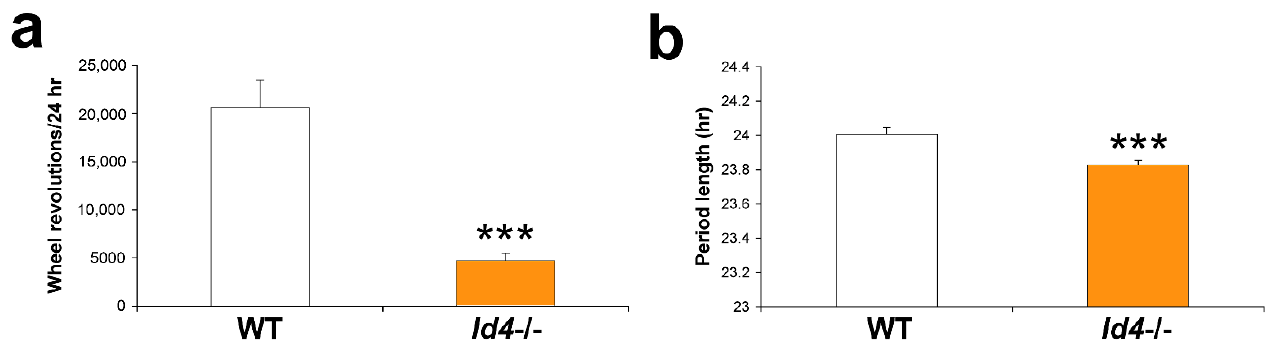
Figure 1. Mice null for the Inhibitor of DNA binding 4 ( Id4 ) gene ( Id4 − / − mice) show a reduction in the magnitude of wheel activity and a shorter free-running period length. ( a ) Wheel revolutions and ( b ) circadian period length for wild-type (WT) (white) and Id4 − / − (orange) mice. See Figures 2– 4 for representative locomotor activity records (actograms). *** p < 0.001.